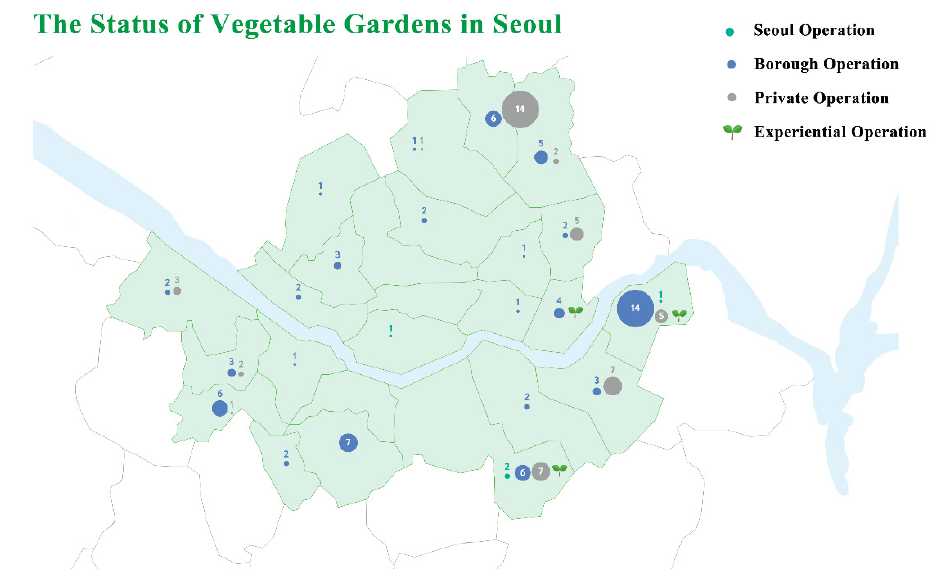
Figure 7. The Status of Vegetable Gardens in Seoul [54].